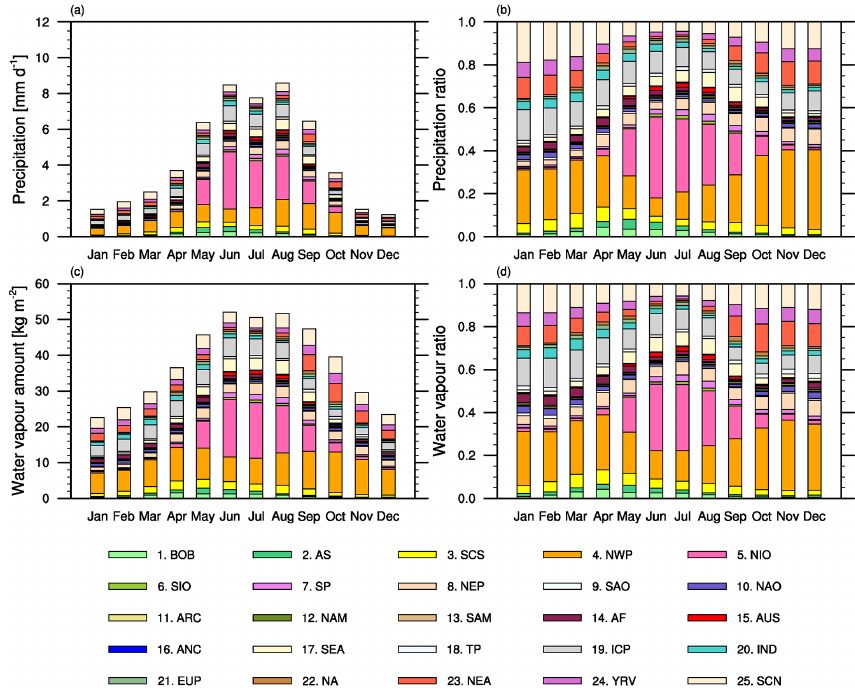
Figure 7. Same as Fig. 6, but for the contributions and relative contributions of 25 source regions to precipitation and tropospheric total water vapour amount over